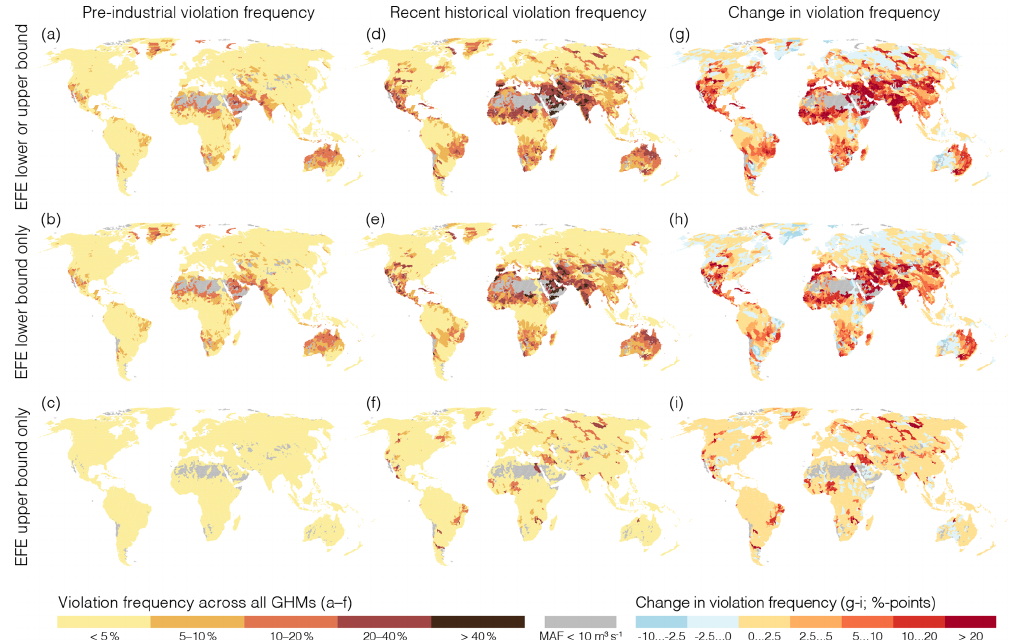
Figure A4. Frequency of environmental flow envelope (EFE) violations between 1801 and 1860 (a–c) , between 1976 and 2005 (d–f) , and the change in violation frequency between these two periods (g–i) . The maps are separated by violations of both upper and lower bounds (a, d, g) , lower bound only (b, e, h) , and upper bound only (c, f, i) . All values are computed across four global hydrological models (GHMs). Sub-basins with mean annual flow (MAF) less than 10m 3 s − 1 at the sub-basin outlet are